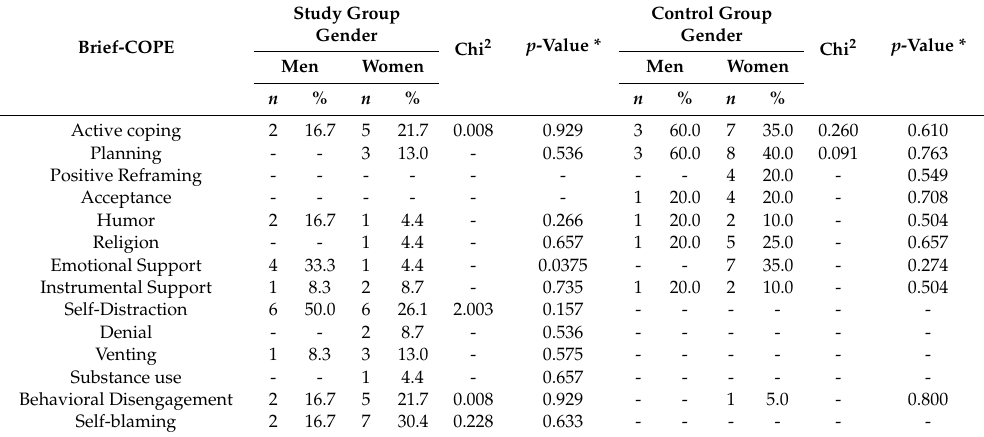
Table 7. Comparison of the frequency of selected methods of coping with stress by men and women from the study and the control